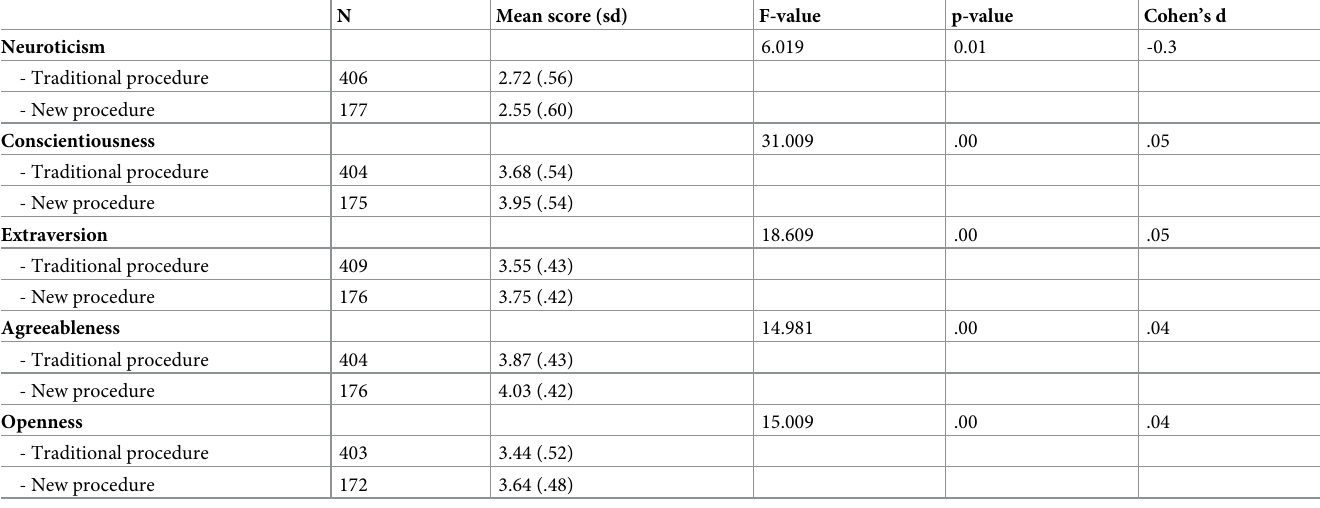
Table 2. Big Five personality scores of students of two admission routes, adjusted for